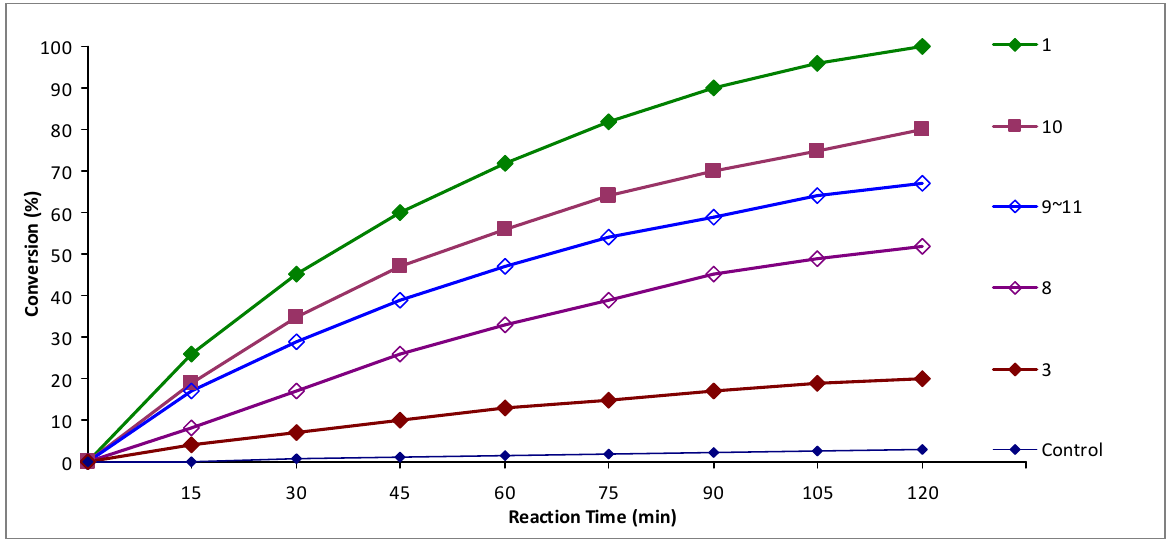
Figure 1. The assessment of glutathione peroxidase-like activity of divinyl selenide 1 and bis(2-bromovinyl) selenides 3 , 8 – 11 by 1 H-NMR monitoring.